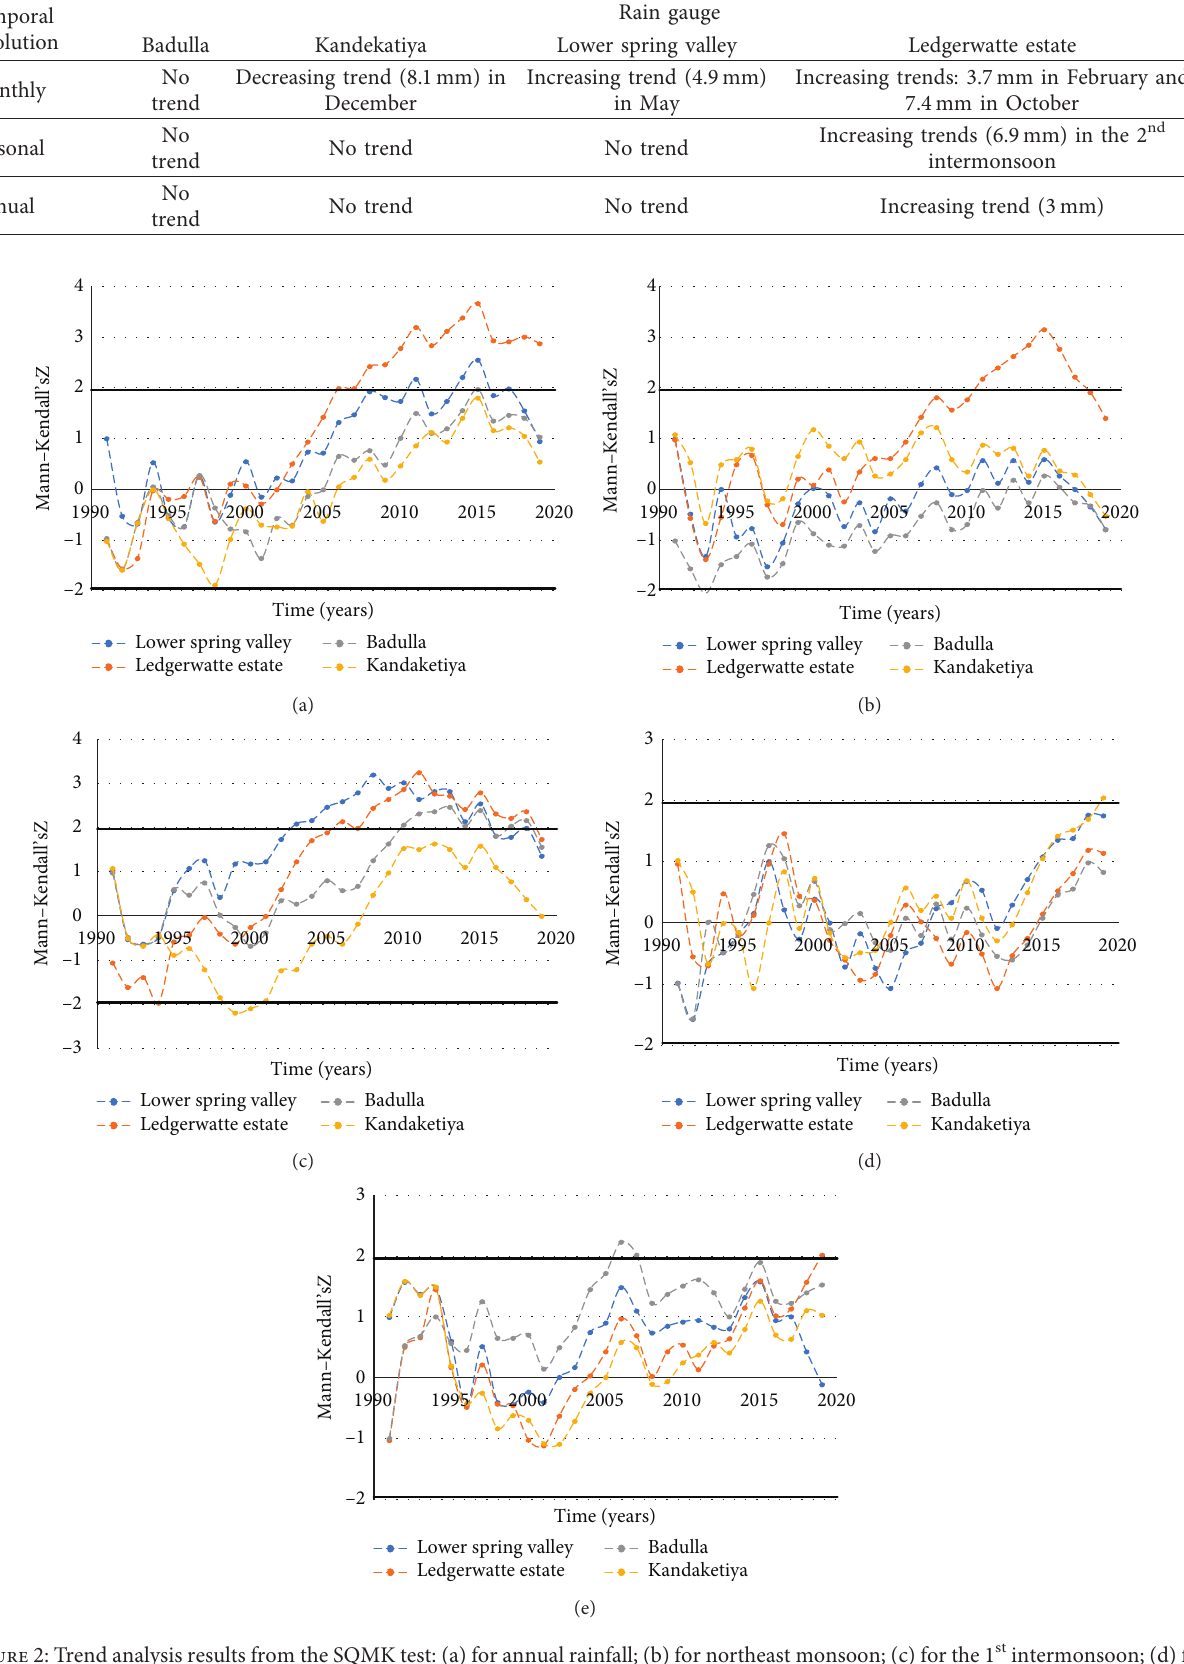
Table 1: Trend analysis results from the MK test.